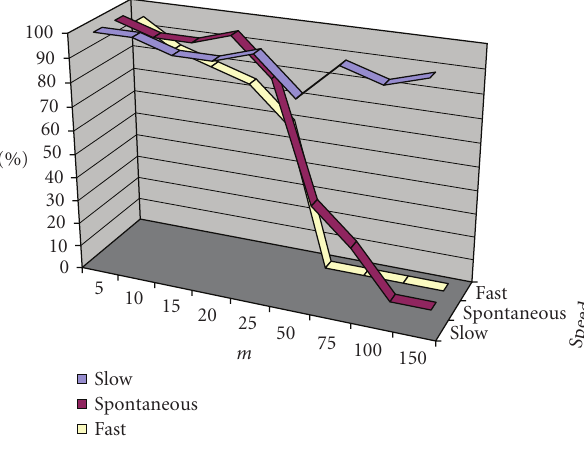
Figure 12: Successful recognition percentage as function of the recognition window and of speed of